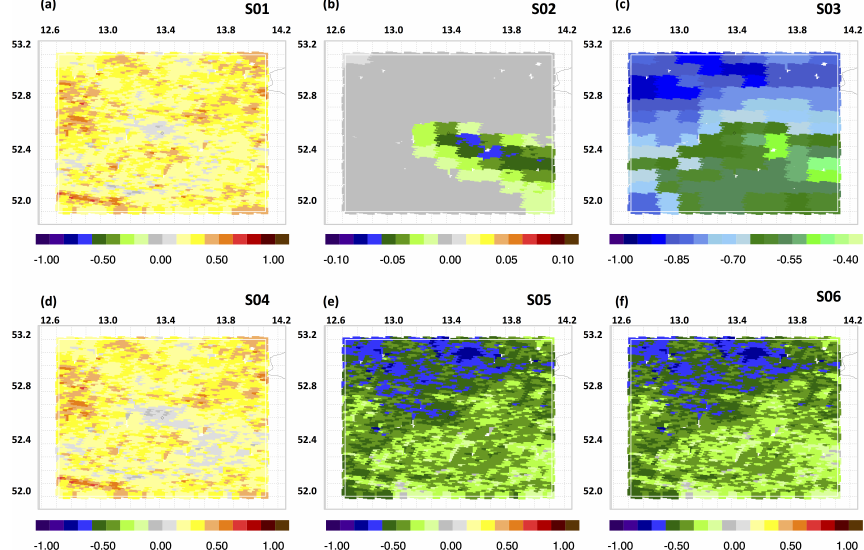
Figure 7. XCO 2 systematic error over the target region on 24 June 2008, assuming a CarbonSat swath width of 500km. The six scenarios (S01–S06) are shown with a label inside the respective panel. For S01, S02, and S04, these errors are estimated using the error parameteri- zation scheme of Buchwitz et al. (2013a). The other scenarios additionally utilize biogenic XCO 2 variability in the target region (simulated by WRF-GHG) to derive XCO 2 systematic errors. Note that different colour scales are used for S02 and S03. All units are given in